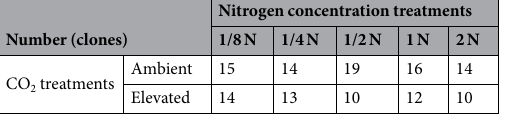
Table 2. The number of sequenced clones from each PCR product.